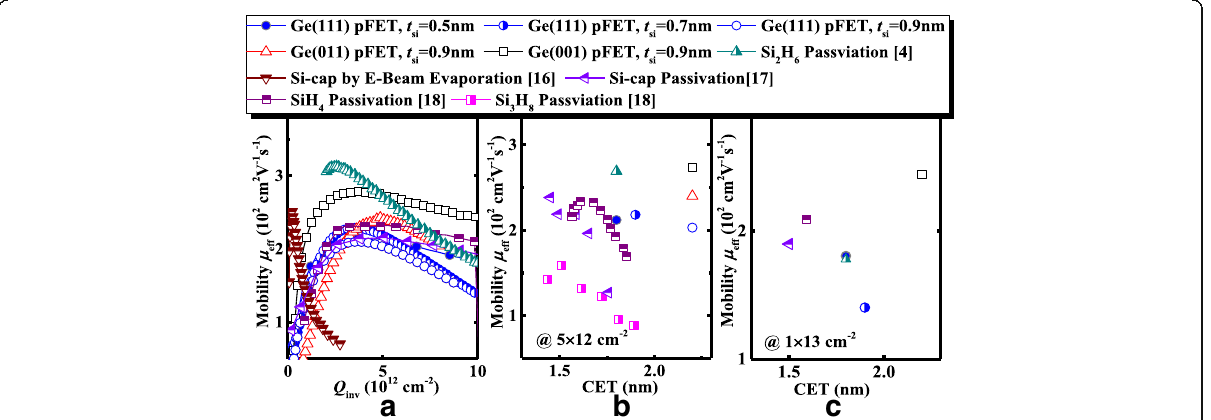
Fig. 10 a μ eff for the Ge pMOSFETs in this work vs. the published results for relaxed Ge pMOSFETs. b , c Benchmarking of μ eff extracted at Q inv = 5 × 10 12 and 1 × 10 13 cm − 2 , respectively, of the Ge pMOSFETs with the different CET values [18,